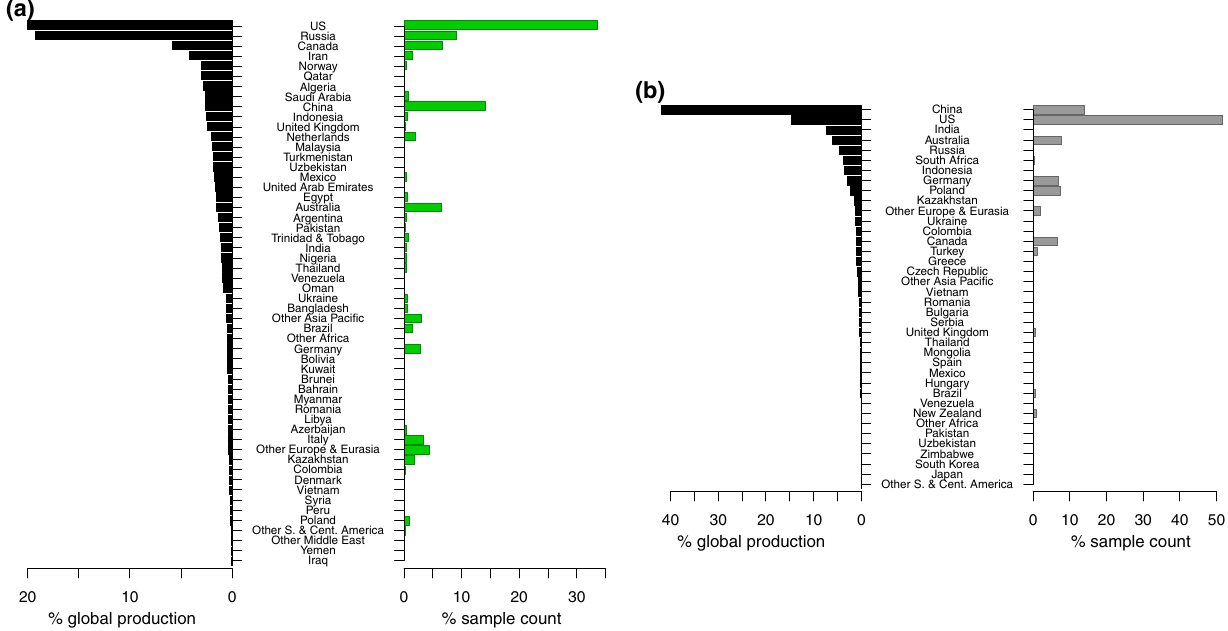
sample counts versus production statistics for (a) conventional natural gas and (b) coal. Shale gas is not Figure 3. Tornado plots of δ 13 C CH 4 included because it is primarily from the US and Canada. “Other Asia Pacific” represents Afghanistan, Japan, New Zealand, and Taiwan; “Other Africa” represents Angola and Tunisia; “Other Europe & Eurasia” represents Austria, France, Hungary, Lithuania, and Turkey; “Other South and Central America” represents Barbados; “Other Middle East” represents